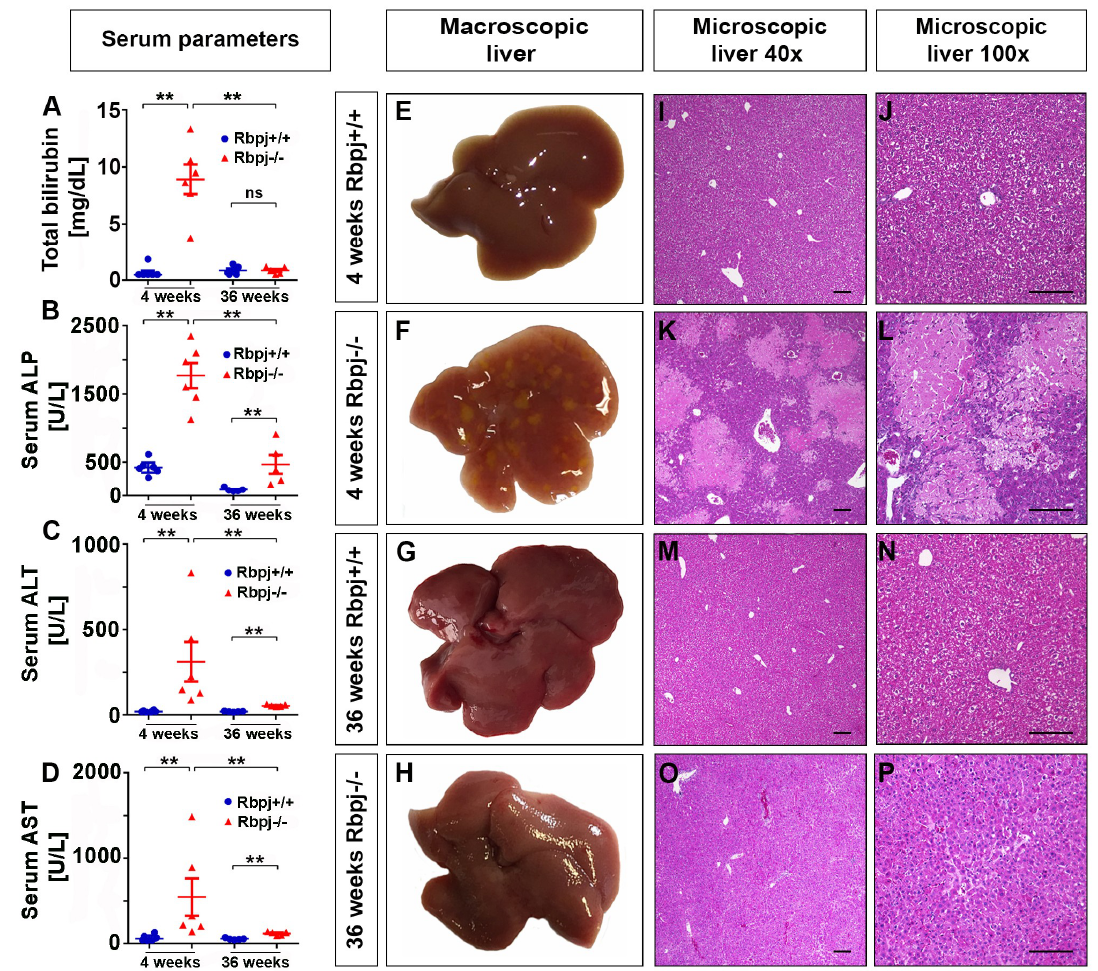
Figure 3. Loss of RBPJ results in cholestasis and hepatic necrosis. ( A – D ) Serum parameters indicating liver inflammation and cholestasis. Scatter dot plots of ( A ) TB (total bilirubin (mg/dL)), ( B ) ALP (alkaline phosphatase (U/L)), ( C ) ALT (alanine transaminase (U/L)), and ( D ) AST (aspartate transaminase (U/L)) measured in mouse serum at 4 and 36 weeks from Rbpj +/+ and Rbpj −/− mice ( n = 5–6; ** p ≤ 0.01, Mann–Whitney test (Two tailed)). All four serum parameters are increased in 4-week-old Rbpj −/− mice. ( E – H ) Representative photographs of macroscopic liver from Rbpj +/+ and